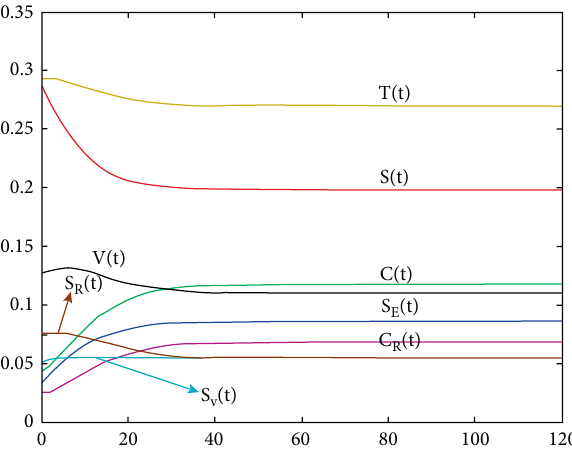
max R R { 0 = 𝐾 , 𝑉 } > 1